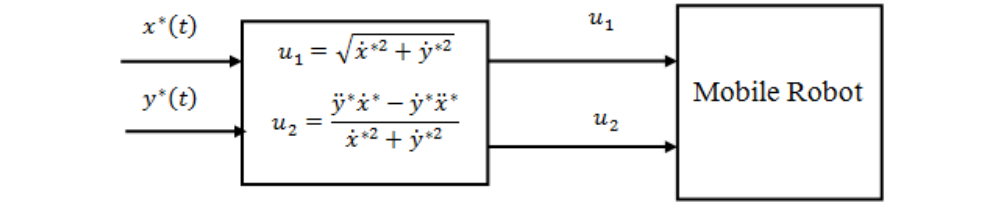
Figure 11. Visual servo control diagram: object leaves the field of view of the camera.